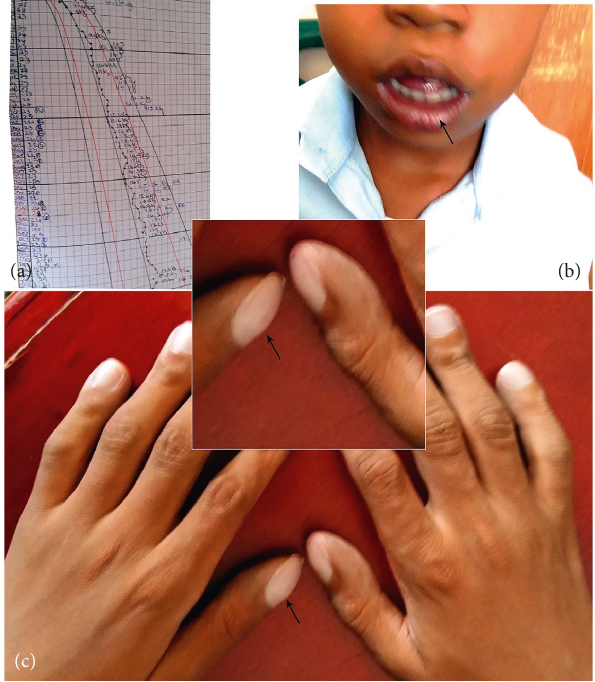
Figure 1: (a) Weight-for-age plot for the patient. Growth consistently above 0 Z-score (middle line on the image) throughout the